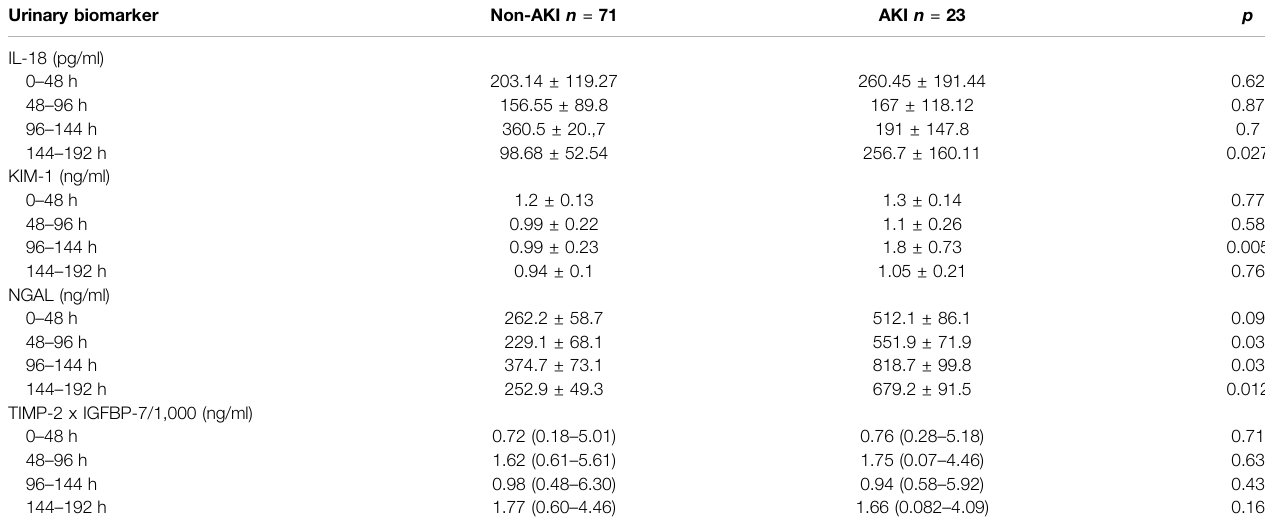
TABLE 2 | Urinary biomarkers values according to the presence of acute kidney injury in patients hospitalized in wards and receiving vancomycin. Urinary biomarker Non-AKI n =